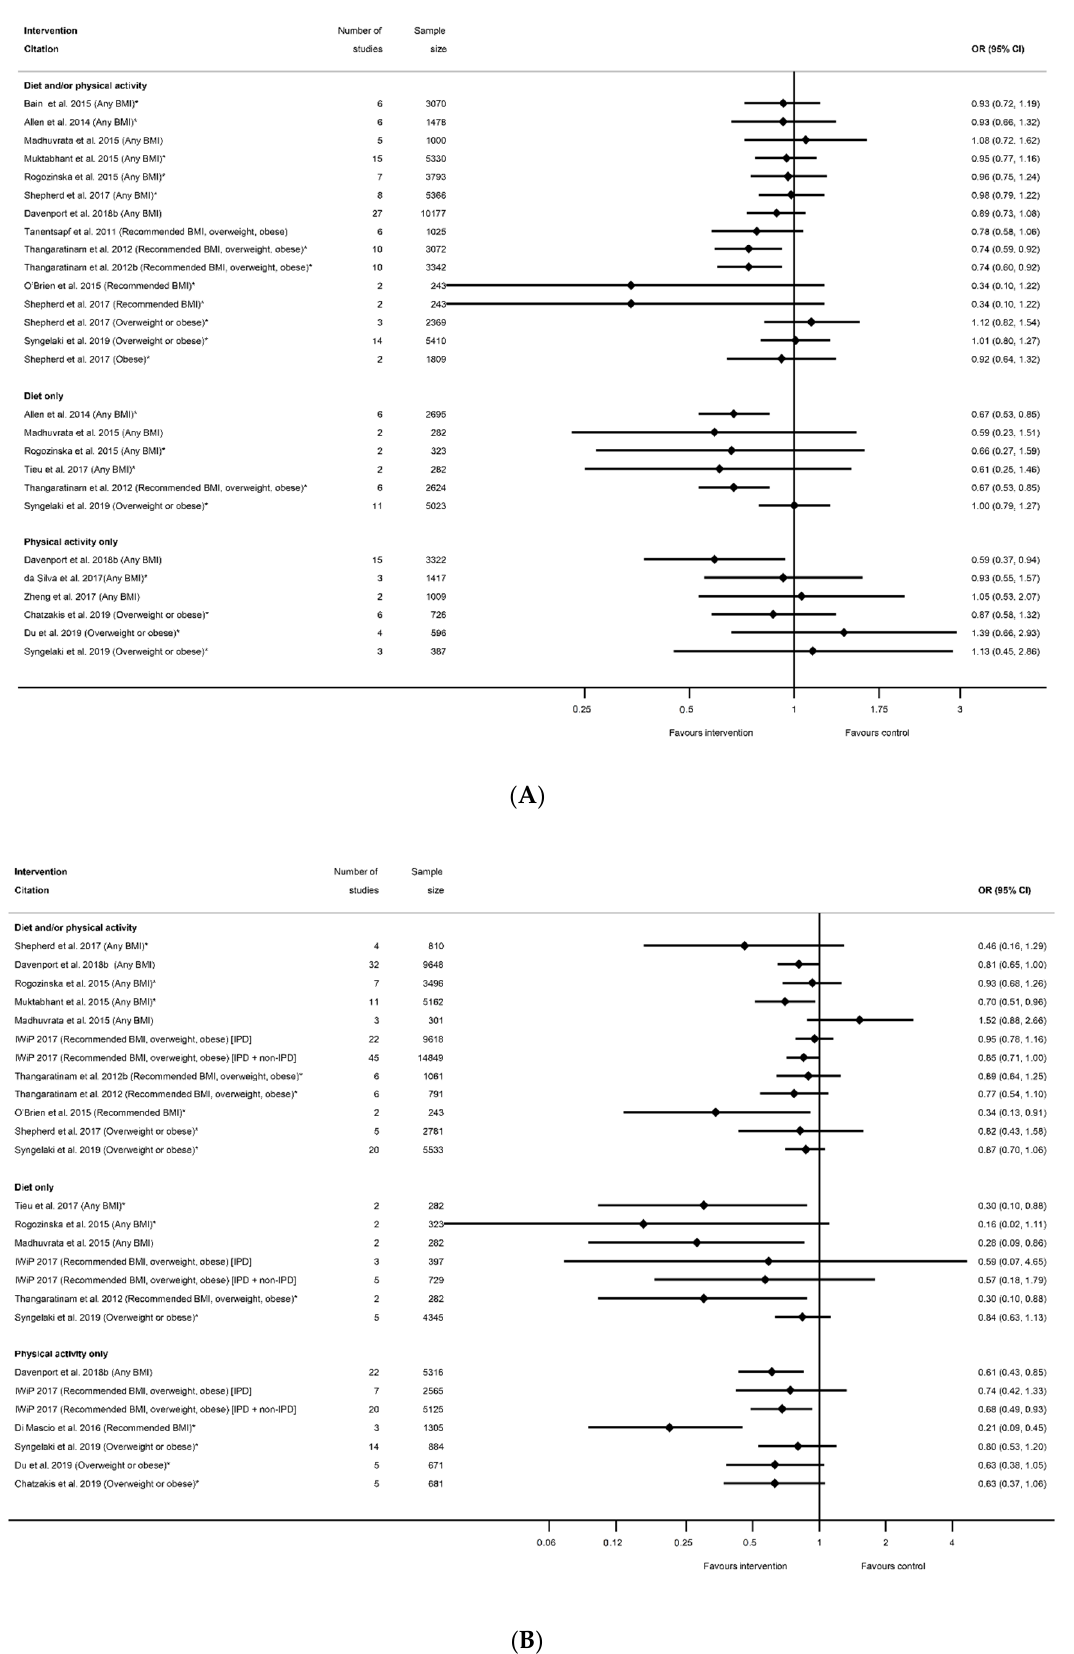
Figure 7. Forest plot of meta-analysis results relating to hypertensive disorders; ( A ) preeclampsia, ( B ) pregnancy induced hypertension. * indicates the estimate is relative